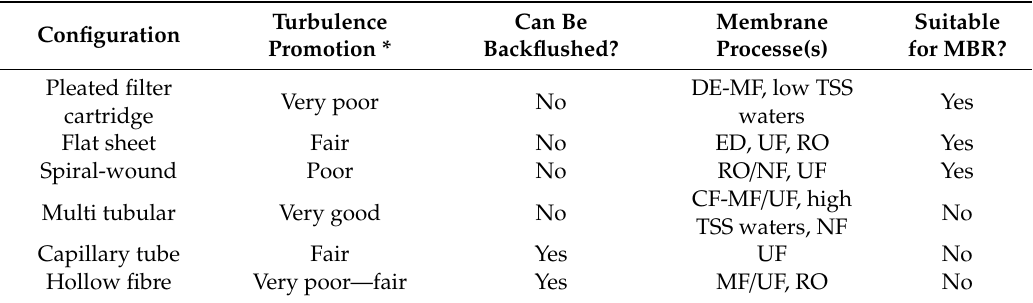
Table 2. Di ff erent membrane configurations in an MBR